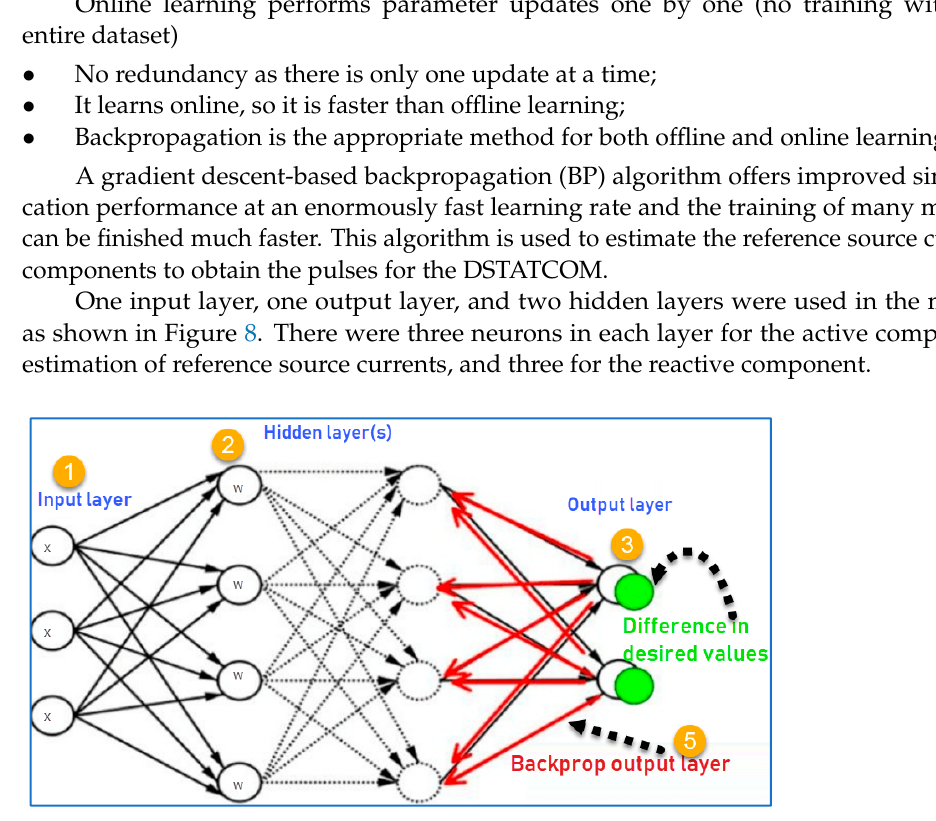
Figure 9. The same ANN model can also be used for unbalanced loads.